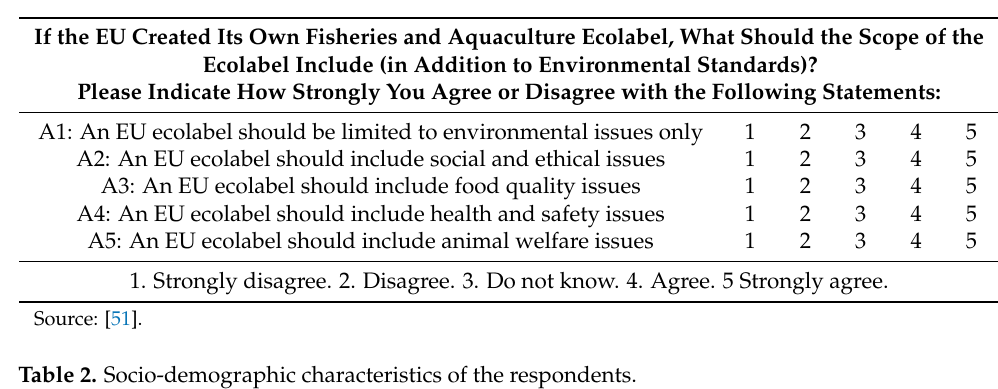
Table 1. Coverage of the EU ecolabel system in fishery and aquaculture products (FAPs).